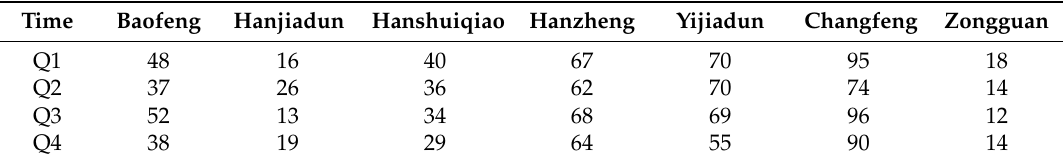
Table 5. Global theft rate ranking of communities in Qiaokou